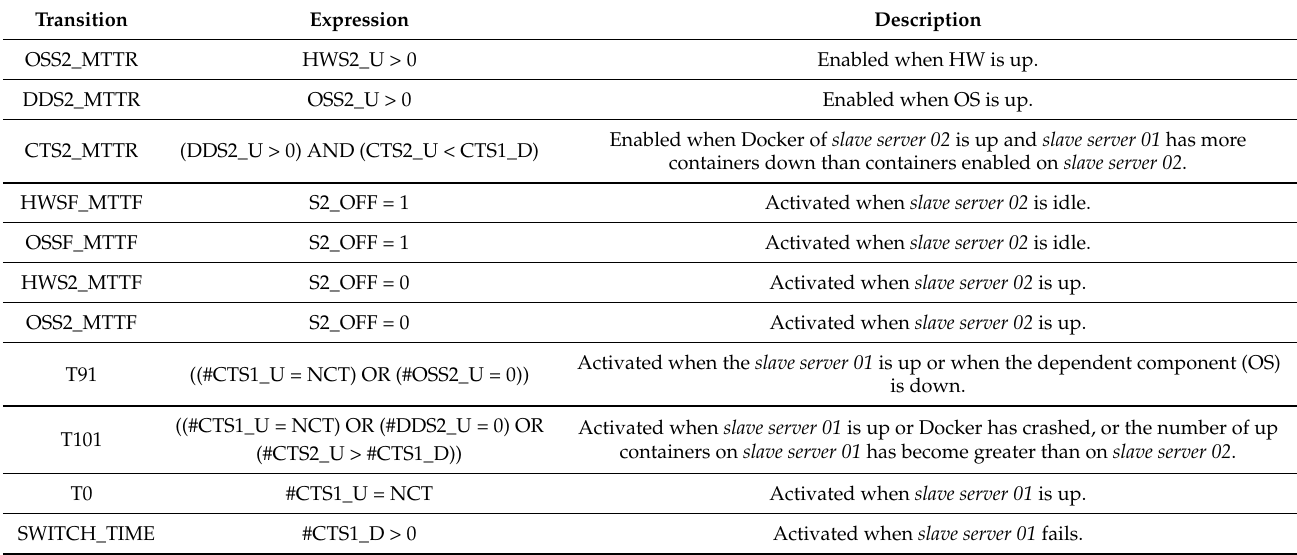
Table 6. Guard conditions to the extended